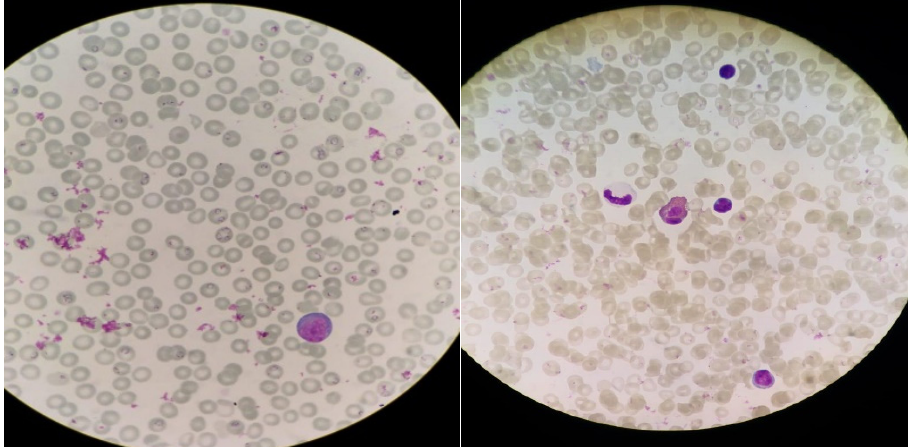
Figure 1. Light microscopy images of thin blood smears. Plasmodium falciparum trophozoites infecting red blood cells at the first day of hospitalization, before artesunate treatment ( left ). Parasitaemia clearance after second dose ( right ).